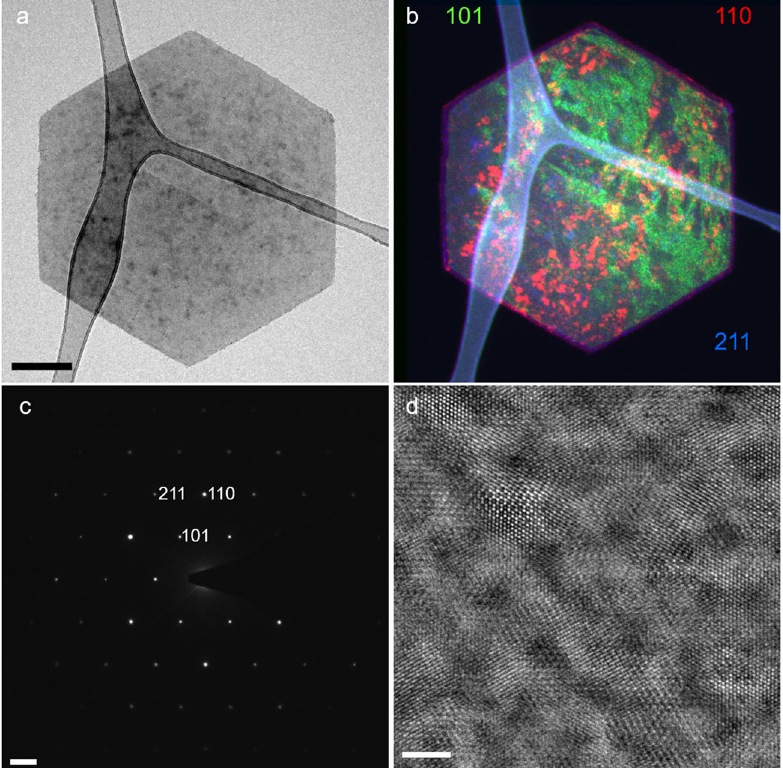
Fig. 2 TEM characterization of Ni – Fe LDH material. a Bright- fi eld TEM image of a representative Ni – Fe LDH nanoplatelet. b Composite dark- fi eld TEM images acquired from the (101), (110) and (211) reciprocal lattice vectors in green, red and blue respectively. c Typical electron diffraction pattern of the Ni – Fe LDH. The {101} and {110} planar families are annotated on the diffraction pattern. d Aberration-corrected STEM micrograph of the Ni – Fe LDH material. Scale bars are 200 nm, 2 nm − 1 and 2 nm for the a BFTEM image, c SAED pattern and d HAADF-STEM micrograph